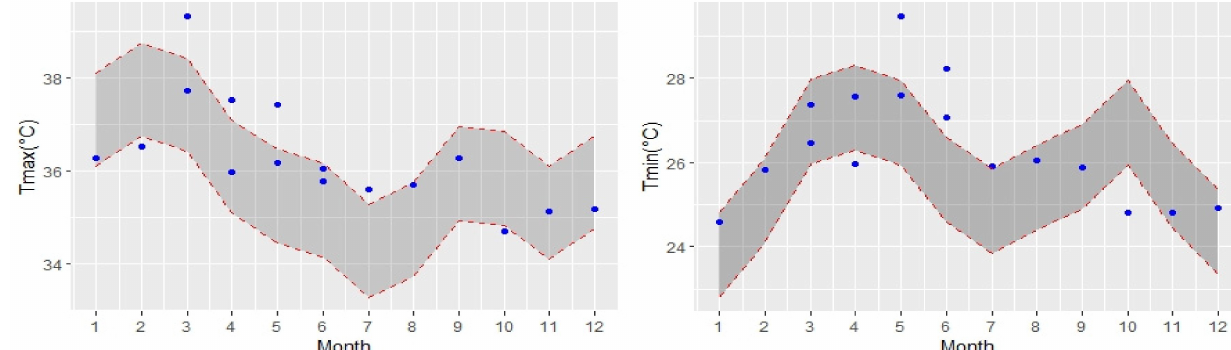
Figure 11. Temperature ranges (gray bands) with an amplitude of 2 degrees centered on the climatological monthly mean values for the selected land-based meteorological station in North Horr for the period 03/19–06/20. Each dot represents one observation. Red dashed lines represent the upper and lower limits of the